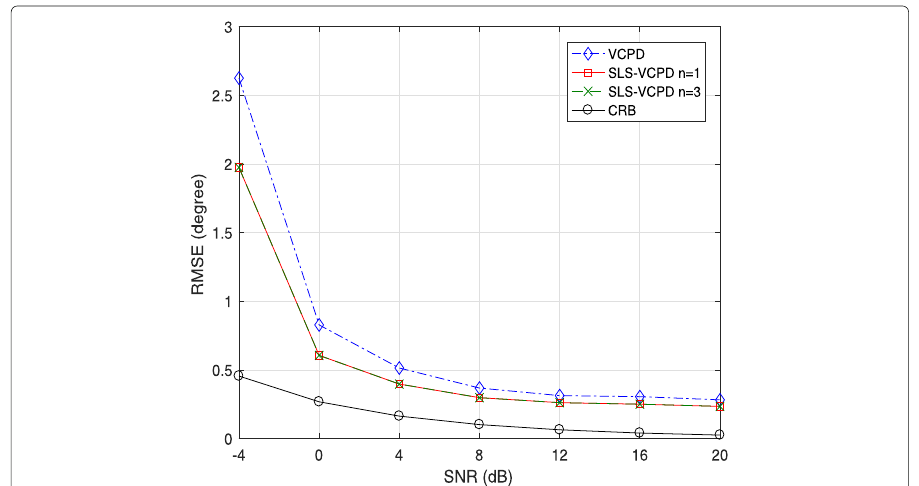
Fig. 7 Performance analysis of the influence of iteration number of the RMSE versus SNR for four signals with M = 6